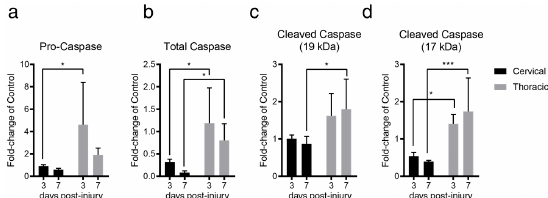
Figure 3. SCI results in changes to splenic pro-caspase-3, caspase-3, and cleaved caspase-3 in a level-dependent and time-dependent manner. ( a ) tSCI displayed a marked upregulation of splenic pro-caspase-3, 3-days post-injury relative to cSCI (two-way ANOVA, * p = 0.0156, t = 3.038, DF = 16, n = 5 / group, 95% CI of di ff . − 6.69 to − 0.69. Sidak’s multiple comparison test). ( b ) tSCI